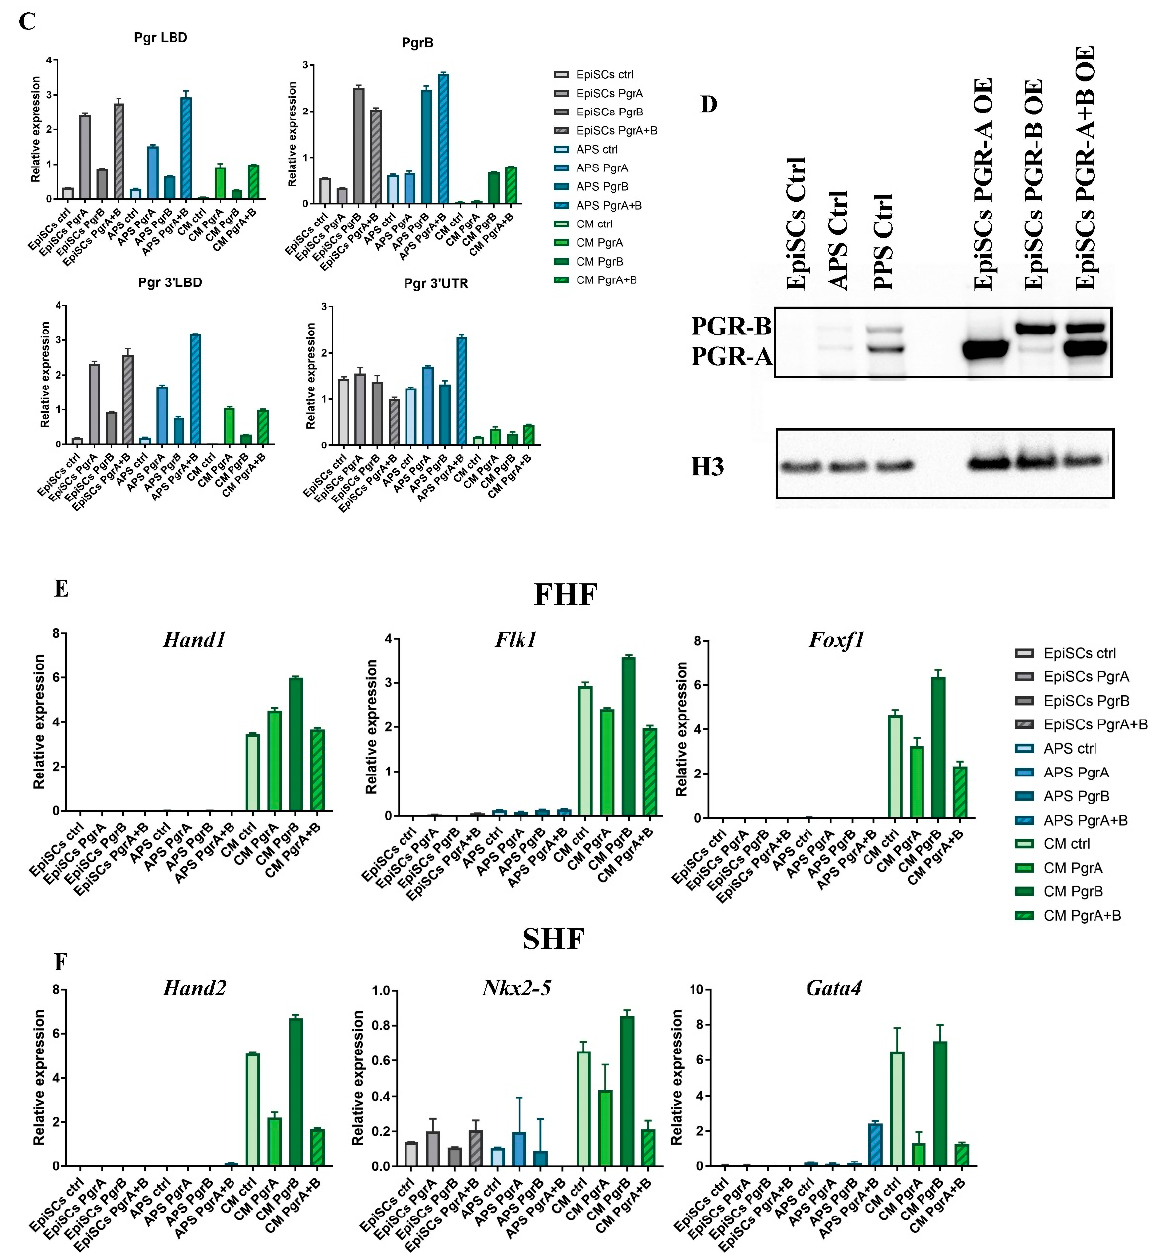
Figure 5. PRG-B and PGR-A selectively regulate FHF vs. SHF cardiac differentiation. ( A ) Illustration depicting PGR protein structure. The long form of PGR, PGR-B, includes the PGR-B-specific domain (dark red), the DNA-binding domain (yellow), and the ligand-binding domain (light red). The short form of PGR lacks the N-terminal PRG-B domain. ( B ) Schematic of the overexpression assay. The sequences of both full-length PGR-B and shorter PGR-A were cloned into a lentiviral vector under the EF1 α promoter. After transduction, cells undergo puromycin selection and differentiation. ( C ) Relative mRNA expression of Pgr isoforms measured by RT-qPCR along differentiation of EpiSCs to APS and CM, confirming overexpression of transduced PGR. ( D ) Western blot showing the levels of overexpressed (OE) PGR isoforms in EpiSCs. Overexpression of specific isoforms is higher than the endogenous levels in EpiSC, APS, and PPS. ( E ) RT-qPCR analyses of cells overexpressing PGR isoforms showing mild upregulation of the FHF signature Hand1 , Flk1 , and Foxf1 due to PGR-B overexpression. ( F ) RT-qPCR analyses indicate decreased levels for the SHF signature markers ( Hand2 , Nkx2-5 , and Gata4 ) by overexpressing PGR-A isoform.